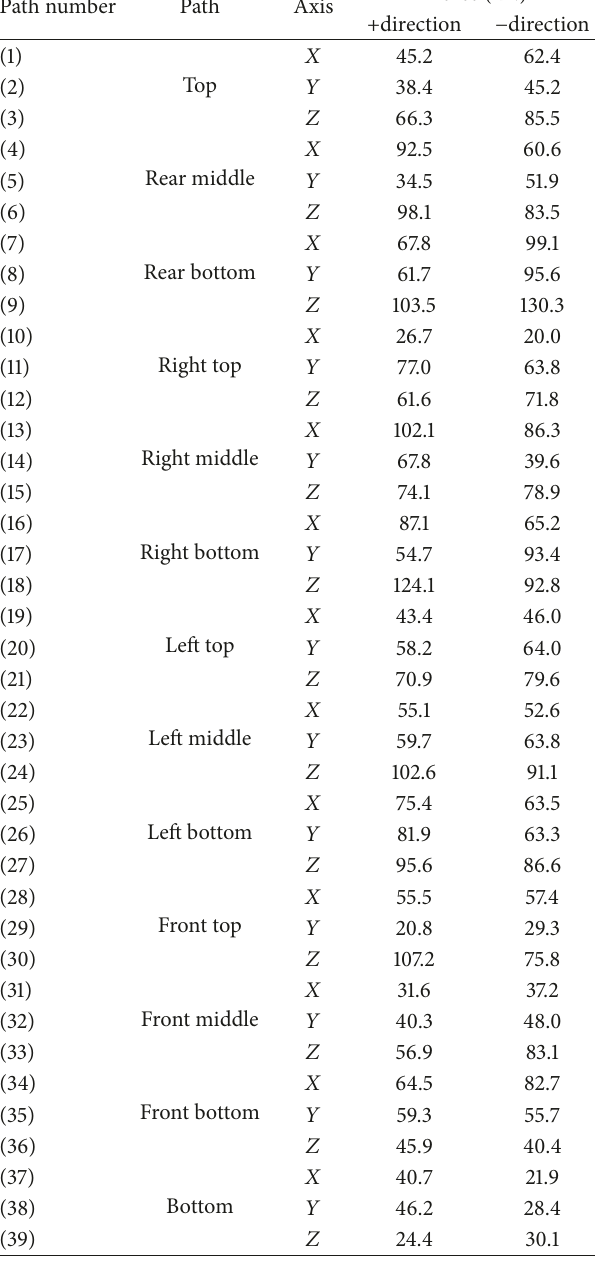
Table 4: Contribution of impact loads in the hydraulic breaker. Path